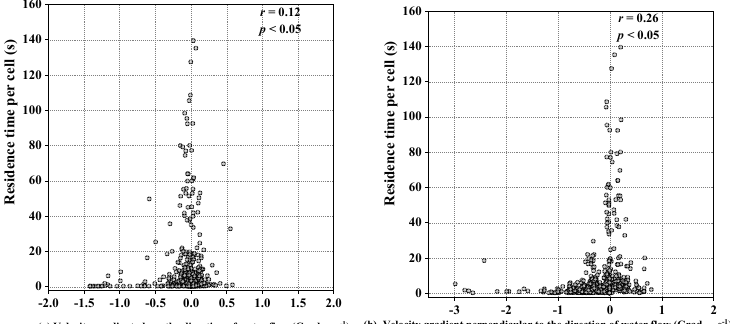
Figure 7. The relationship between the residence time of individual S. prenanti and the different hydrodynamic parameters: ( a ) flow velocity (m/s); ( b ) turbulent kinetic energy (TKE, m 2 · s − 2 ); Reynolds shear stress in three planes: ( c ) RSS xy , ( d ) RSS xz , and ( e ) RSS yz , N . m − 2 ; ( f ) strain rate (SR, s − 1 ); and ( g ) velocity gradient along (Grad vx , s − 1 ) and ( h ) perpendicular to the direction of water flow (Grad vy , s − 1 ). r is the Spearman coefficient, and the p value represents the significance level.